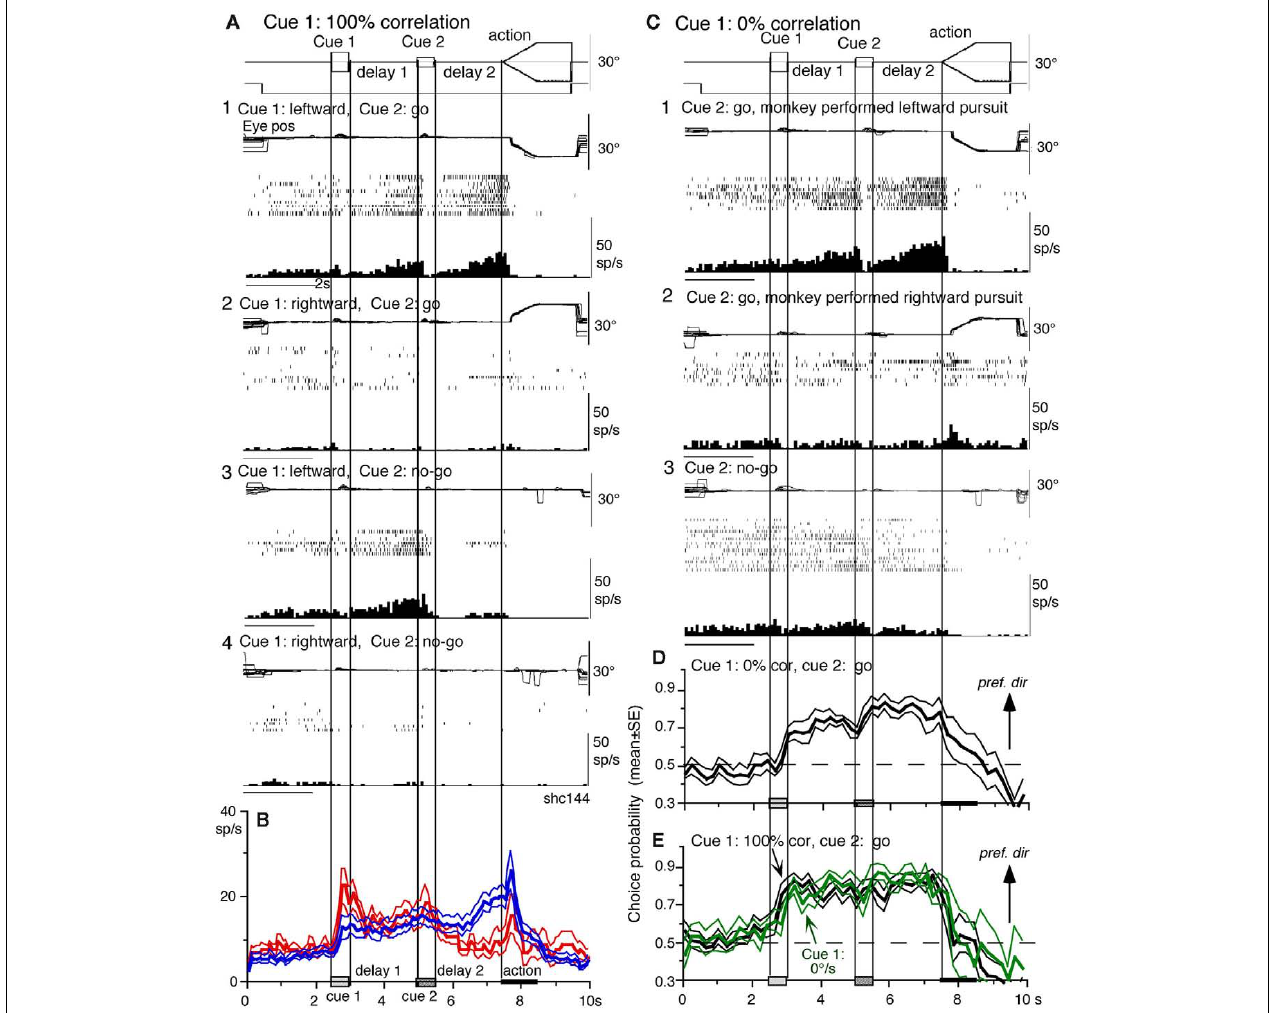
FIGURE 10 |Visual memory + movement–preparation neurons and comparison with visual memory neurons. (A,C) Discharge of a representative SEF visual memory + movement–preparation neuron. Cue 1 motion–direction was presented as 100% correlation (A) and 0%